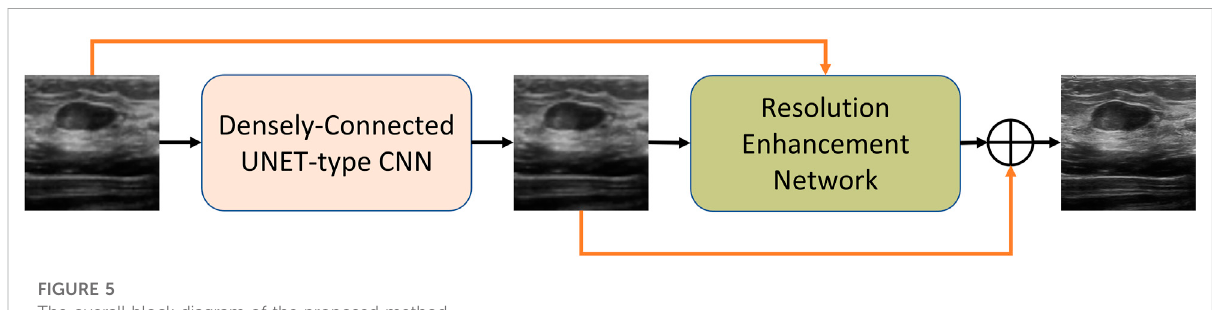
FIGURE 5 The overall block diagram of the proposed